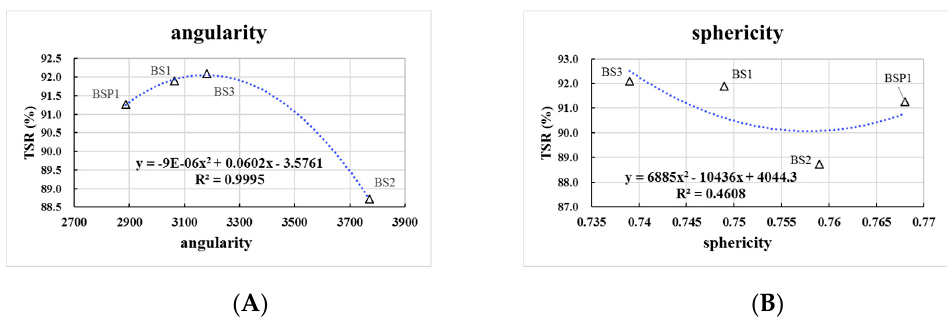
Figure 12. Correlation between splitting test results and aggregate geometric characteristics. ( A ) correlation between TSR and angularity; ( B ) correlation between TSR and sphericity.